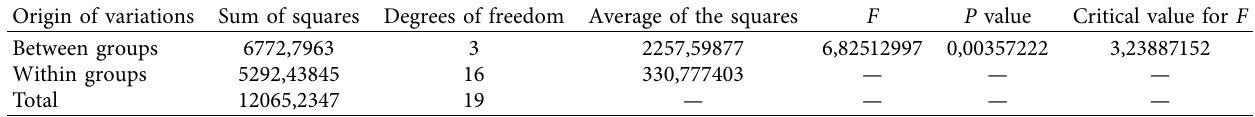
Table 4: ANOVA for the kroE100 instance.